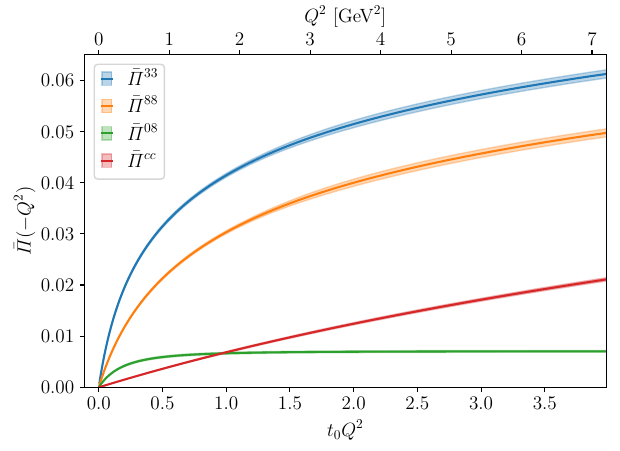
Figure 9 . Contributions to the running extrapolated at the physical point as a function of the momentum transfer squared Q 2 . The contributions are normalized without including the charge factors, according to eqs.